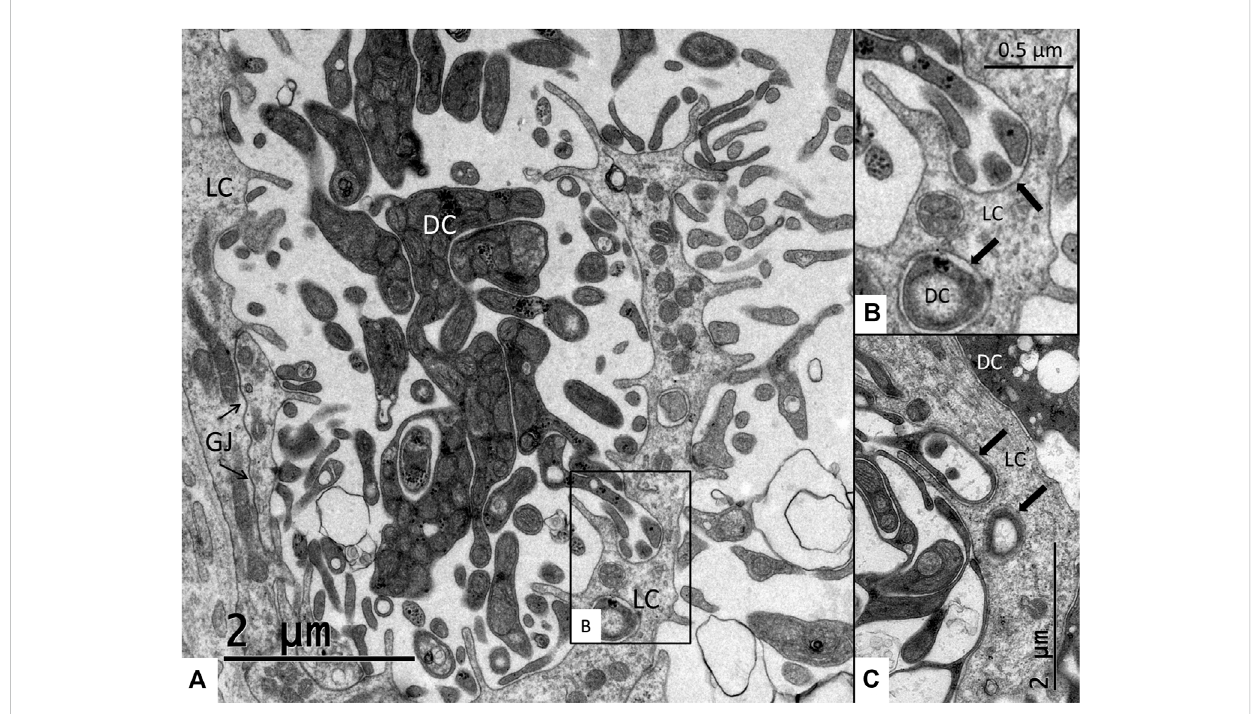
FIGURE 7 (A) Interaction between the light cells (LC) and dark cells (DC). Light cells are connected with extensive gap junctions (GJ). (B) Higher magni fi cation offramedareain (A) .Darkcellprocessesprojectdeepintothecytoplasmofthelightcells. (C) Darkcellprocessesandlightcellsmembranesadhereclose to each other (arrows).